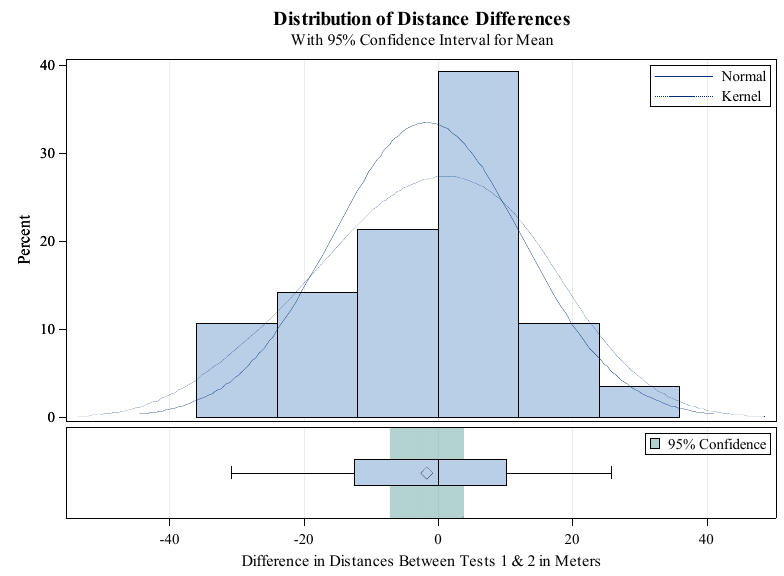
Figure 4. Difference (in meters) between duplicated 6 ‐ min walk tests on Day 3.